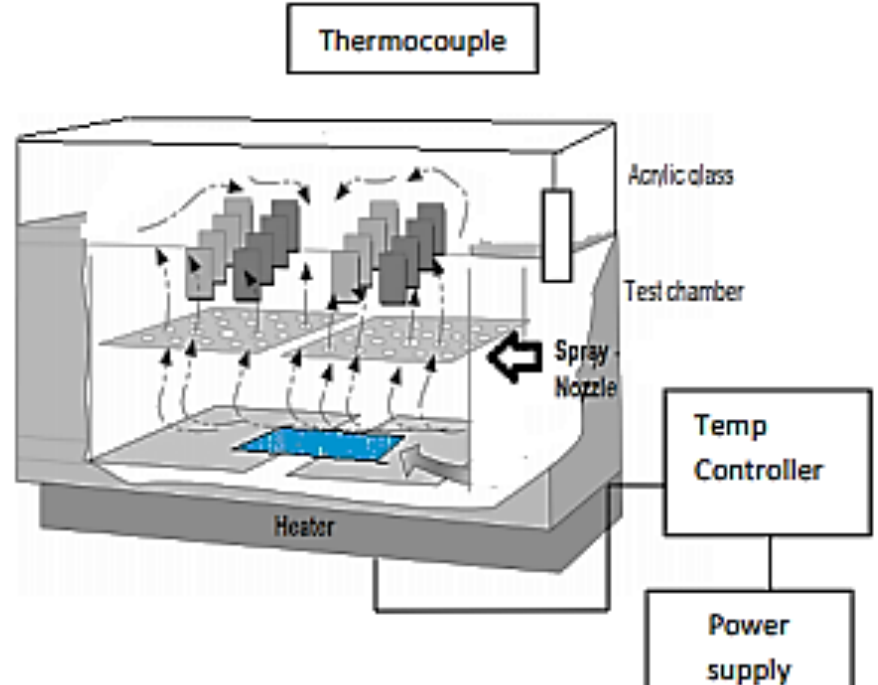
Figure 2. Block diagram of corrosion chamber.